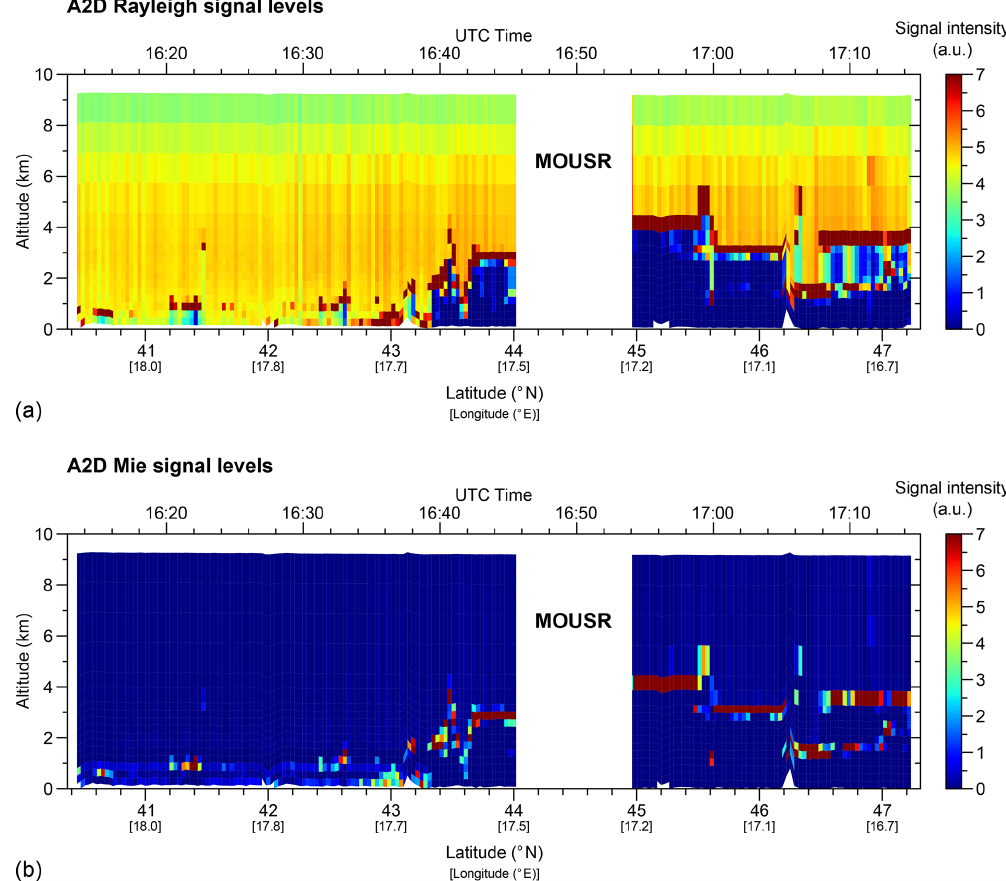
Figure 3. Background and DCO-corrected signal levels from (a) the A2D Rayleigh channel and (b) the Mie channel measured during the underflight on 22 November 2018 between 16:14 and 17:14UTC along the Aeolus measurement track. Between 16:45 and 16:54UTC, the A2D was operated in a different mode (MOUSR) that aimed to detect the Rayleigh background signal on the Mie